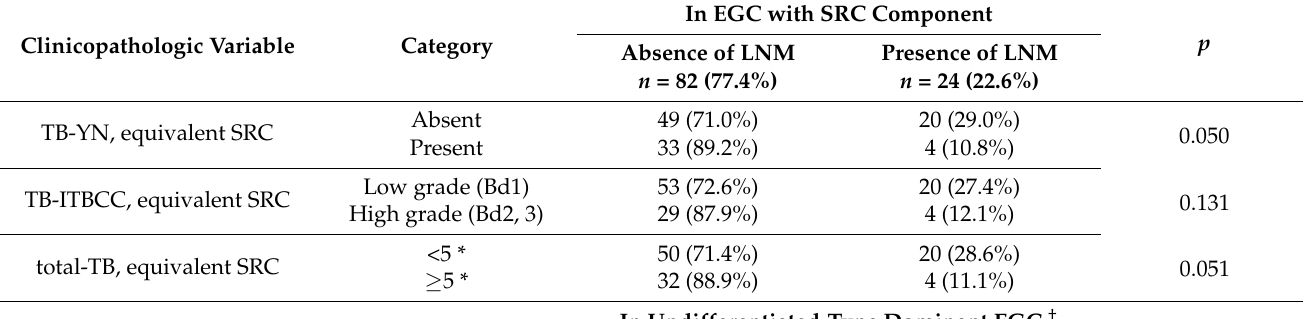
Table 2. Association of morphologically signet ring cell-equivalent tumor budding and lymph node metastasis in early gastric cancer with signet ring cell component and undifferentiated-type dominant. There are no associations with lymph node metastasis; therefore, excluding signet ring cell is